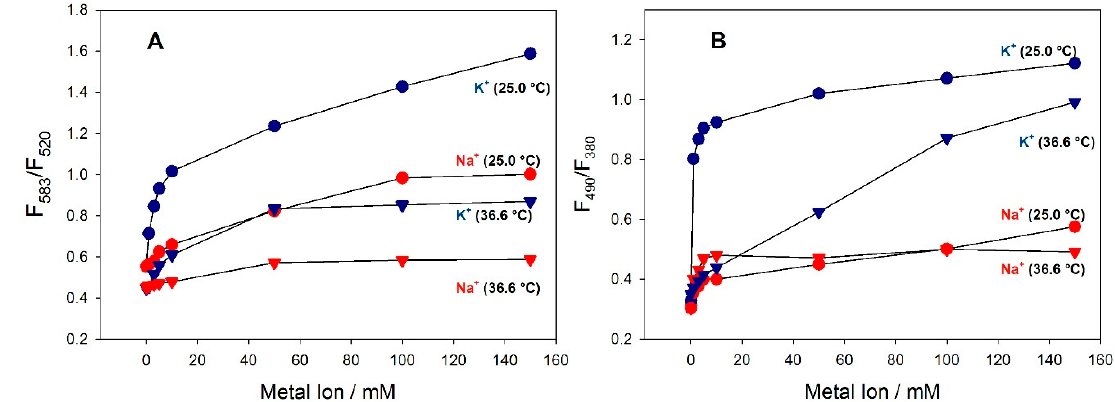
Figure 2. Fluorescence intensity ratio of Ch(F-TBA-T) (F 583 /F 520 ) ( A ) and Ch(py-TBA-py) (F 490 /F 380 ) ( B ) systems plotted against K + or Na + concentration at 25 °C and 36.6 °C.